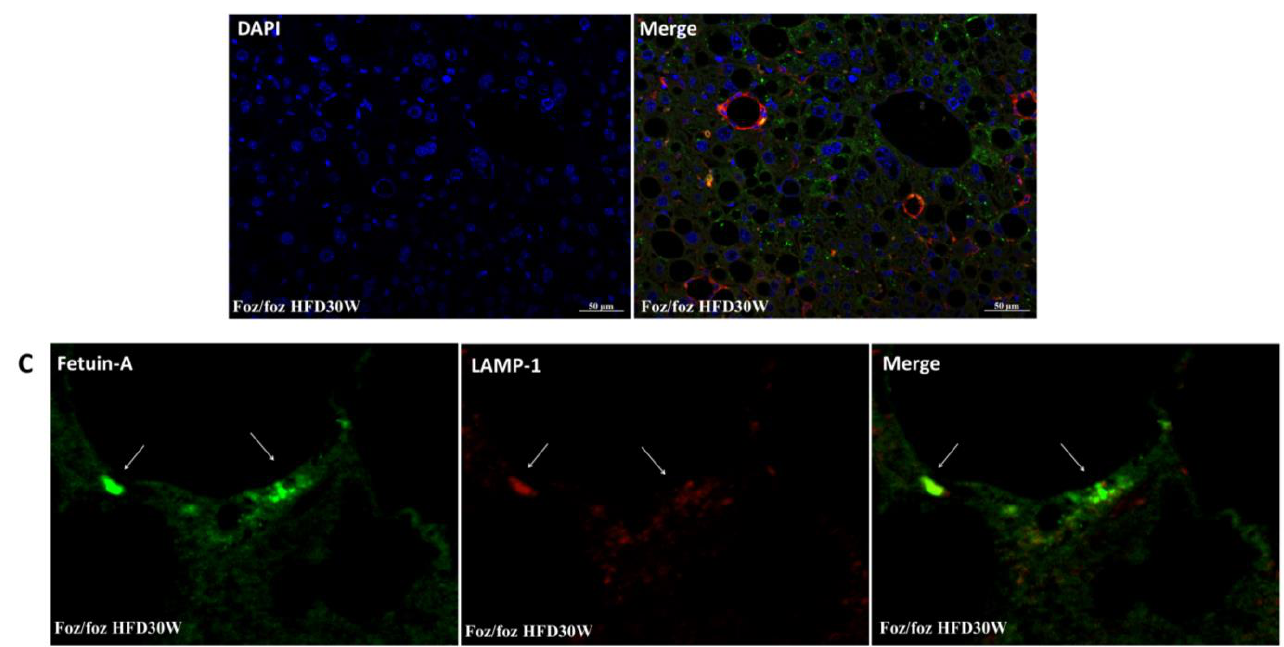
Figure 4. Fetuin-A is present in hepatocytes but also in activated macrophages in steatohepatitis. Immunofluorescence detection of fetuin-A (green) and hepatic macrophages (red) in a healthy liver of a foz − / − mouse on a normal diet for 4 weeks (ND4W) or a high fat diet for 4 weeks (HFD4W). CV: centrilobular vein, PT: portal tract, arrow indicates concentration of fetuin-A in the cytoplasm of steatotic hepatocytes ( A ). Immunofluorescence detection of fetuin-A (green) and hepatic macrophages (red) representative of the group of mice fed a high fat diet for 30 weeks (HFD30W) with fetuin-A positive lipogranulomas ( B ). Immunofluorescence of fetuin-A (green) and lysosomal protein LAMP-1 (red) in the liver of a foz − / − mouse representative of the high fat diet group (HFD30W). Image centered on a cluster of fetuin-A collocated with LAMP-1 ( C ).